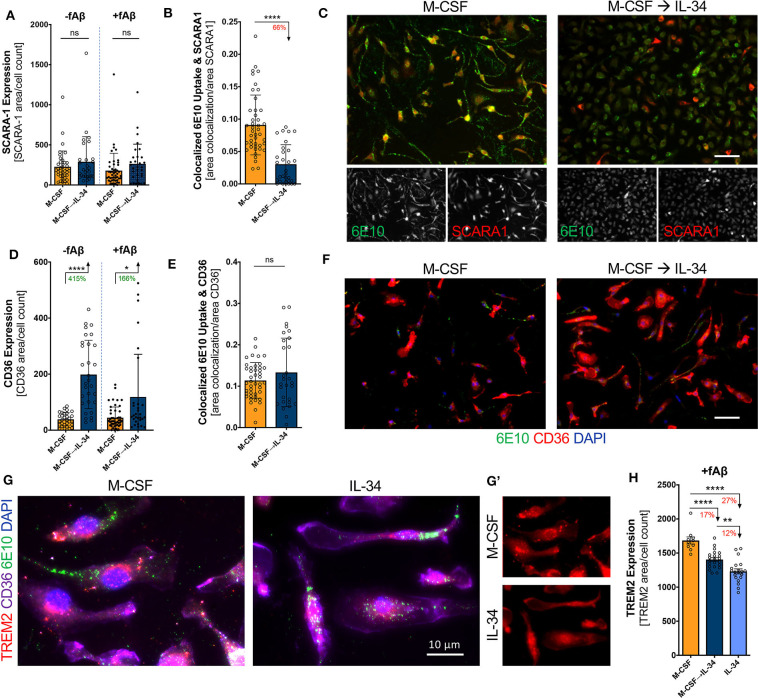
IL-34 treatment alters surface expression of scavenger receptors and co-localization with fibrillar Aβ42 on macrophages. Quantitative ICC analyses assessing SCARA-1 expression (A) and co-localized fibrillar (f)Aβ42 and SCARA-1 (B). (C) Representative images of SCARA-1 surface expression and fAβ42 uptake following 30-min phagocytosis assay. Quantitative ICC analyses assessed for CD36 expression (D) and co-localization with fAβ42
(E). (F) Representative images of CD36 expression and fAβ42 uptake following 30-min phagocytosis assay. (G) Representative images of TREM2 expression in macrophages in the presence of fAβ42. (G') The single channel images showing surface TREM2 (red). (H) Quantitative ICC analyses assessed for TREM2 expression in macrophages for the three cytokine regimens and following fAβ42 exposure. Scale bars are 50 μm, unless otherwise indicated. *P < 0.05, **P < 0.01, ****P < 0.0001, or ns = not significant, by one-way ANOVA with Tukey's post-test or unpaired two-tailed Student t-test.